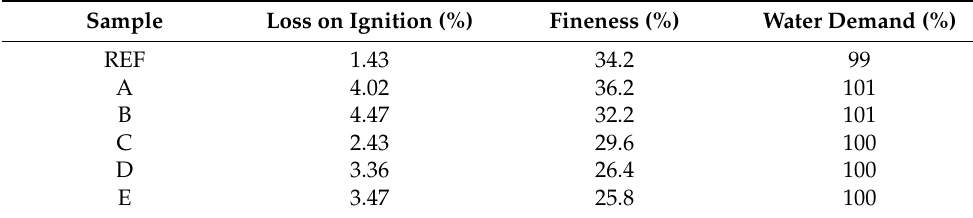
Table 7. Physical characteristics of fly